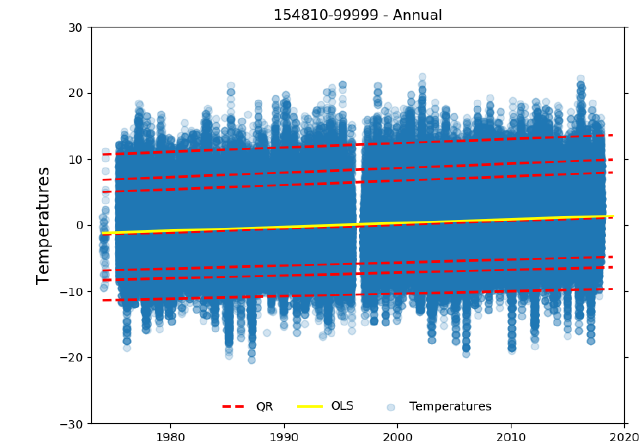
Figure 9. An example of the quantile regression analysis for a sin- gle station, with the trends in the quantiles in red and the ordinary least squares (OLS) fit in yellow. This is for station 154810–99999, Constan¸ta Mihail Kog˘alniceanu International Airport,